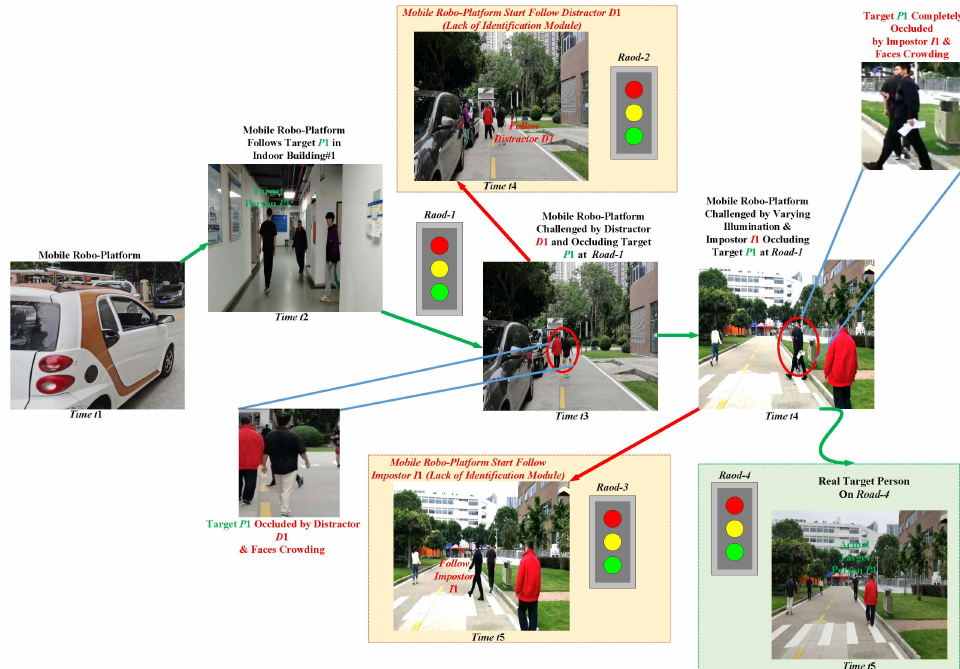
Figure 1. Person-follow robot scenario in outdoor world. The Mobile Roboplatform is Distracted in the Real Multi-Modal Open-Set World During Tracking Target